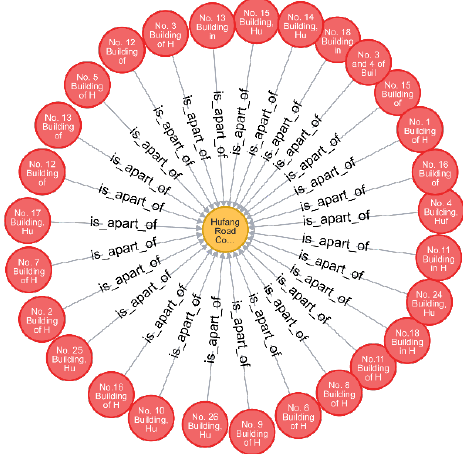
Figure 8 Results of querying ‘Historic Buildings and Historical Buildings Group in Beijing Xicheng District’ with